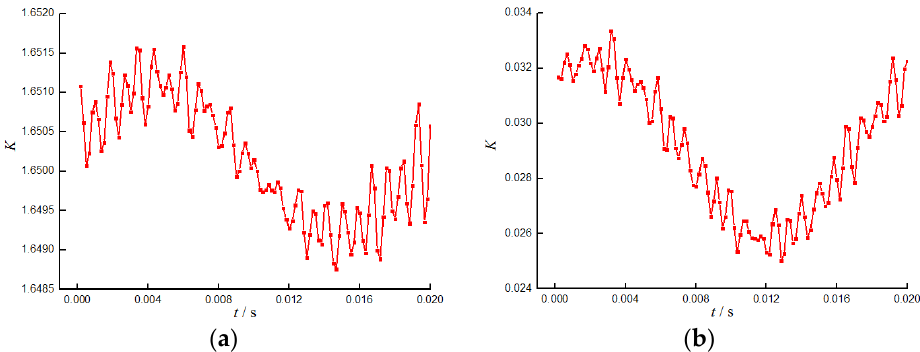
Figure 10. Time-domain results of radial hydraulic forces. ( a ) Turbine suction. ( b ) Turbine impeller.